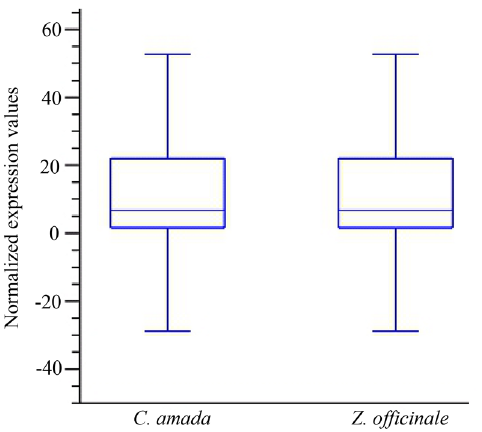
Figure 4. Box plot analysis of read mapping data after quantile normalization in C.amada and Z.officinale transcriptome. The transcript expression values (RPKM) overall distribution and variability of two cDNA libraries/samples were similar, indicating that they were comparable for identification of differentially expressed genes (DEGs) at the transcriptome level.